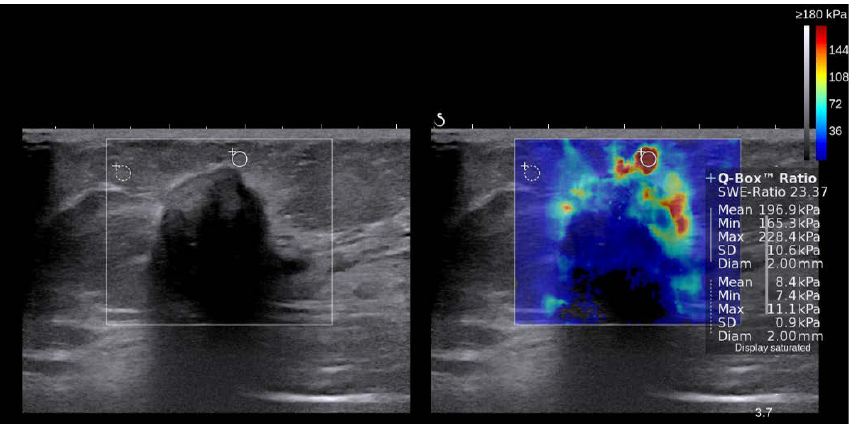
Figure 1. Representative picture of shear wave elastography. A 3.2 cm irregular hypoechoic mass was observed upon US examination. The overlaid semitransparent color reflects tissue stiffness, ranging from dark blue (lowest stiffness) to red (highest stiffness). In this tumor, tumor stiffness is present as mean (196.9 kPa), minimal (165.3 kPa), and maximal (228.4 kPa) elasticity values. The elasticity ratio was calculated by dividing the mean elasticity of the tumor (196.9 kPa) by that of the adjacent stroma (8.4 kPa).